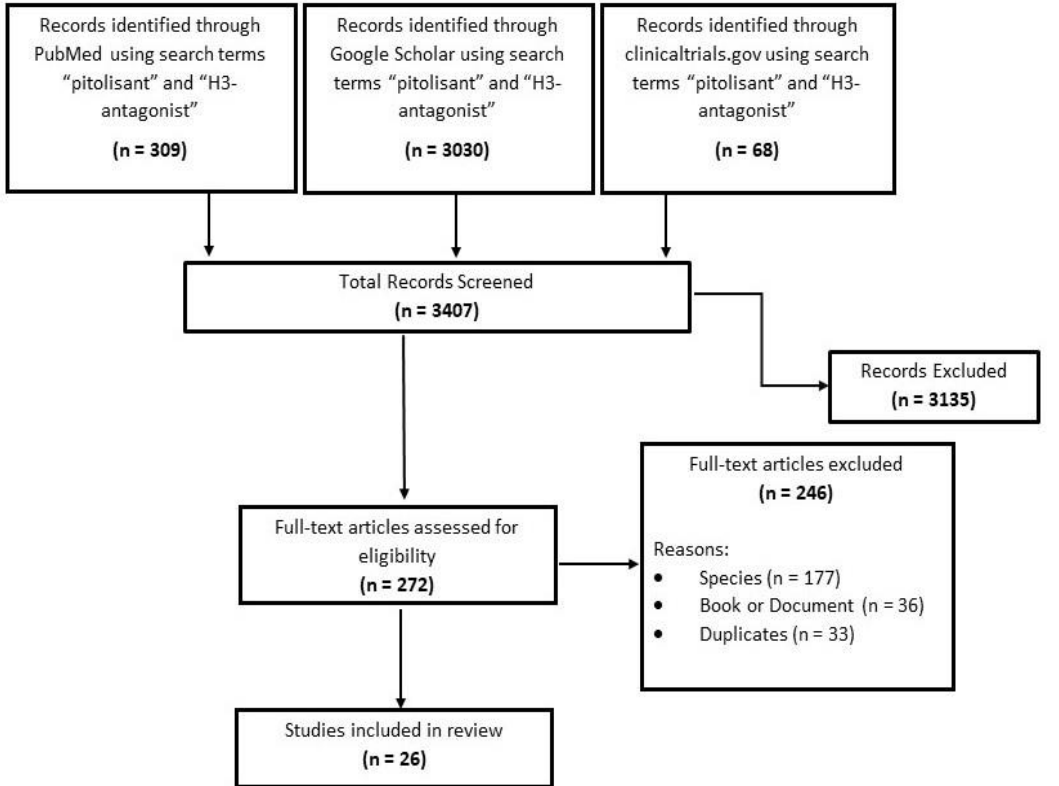
Figure 2. Search results and study selection.